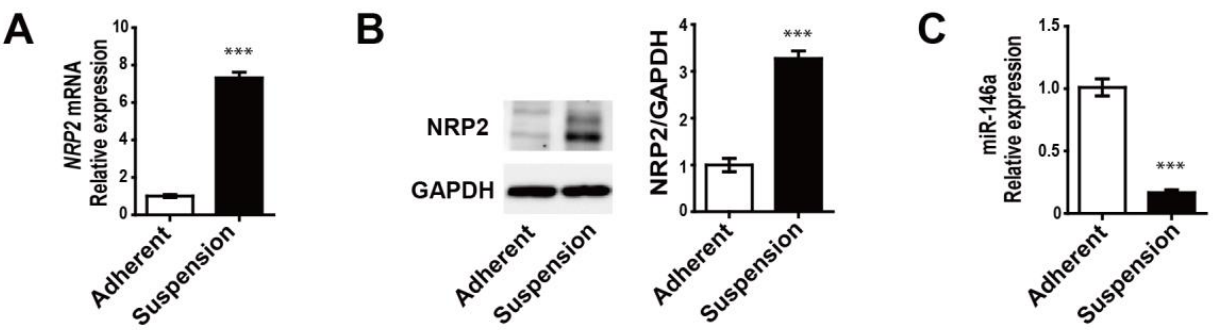
Figure 2. Increased NRP2 expression levels and decreased miR-146a expression levels in MDA-MB-468 suspension cells, according to the mRNA and miRNA sequencing analysis. ( A ) NRP2 mRNA expression in adherent cells and suspension cells. ( B ) NRP2 protein expression in adherent cells and suspension cells. ( C ) MiR-146a expression in adherent cells and suspension cells. *** p < 0.0001 compared to controls calculated via an unpaired two-tailed Student’s t -test. Error bars denote the standard error of the